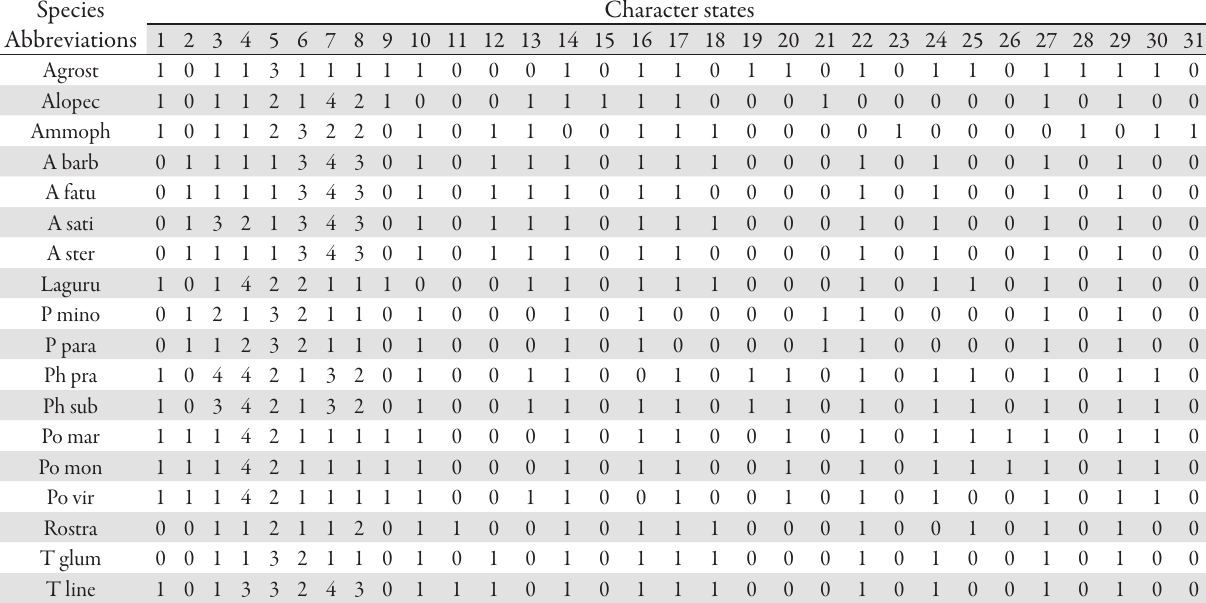
Tab. 4. Distribution of characters among Aveneae species for species abbreviations, see Tab. 2